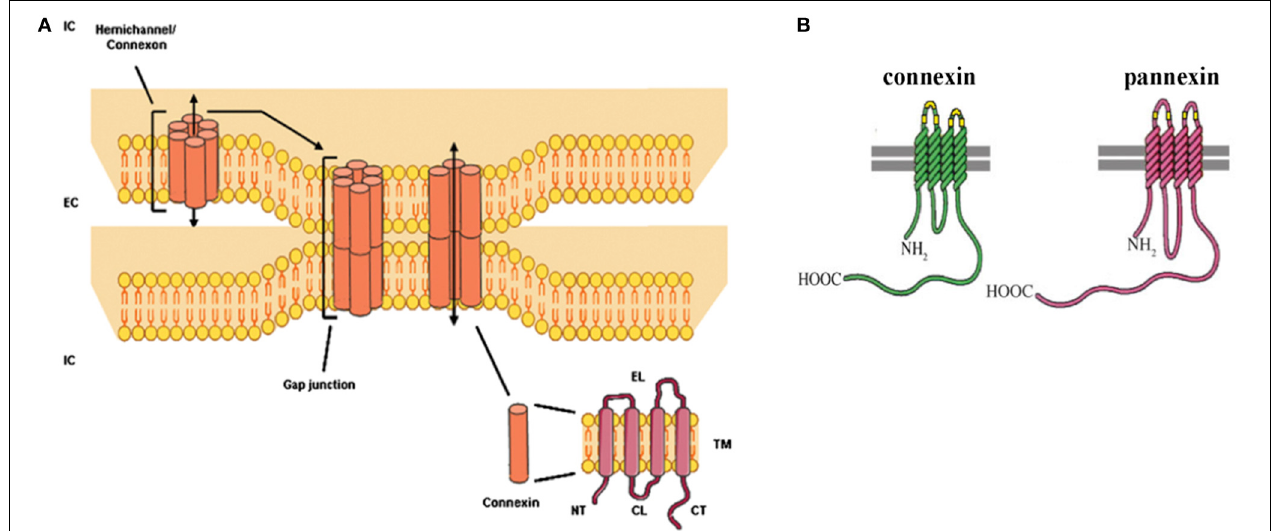
FIGURE 1 | (A) Molecular architecture of gap junctions . Gap junctions are grouped in plaques at the cell plasma membrane surface of 2 adjacent cells and are composed of 12 connexin proteins organized as 2 hexameric hemichannels. The connexin protein consists of 4 membrane-spanning